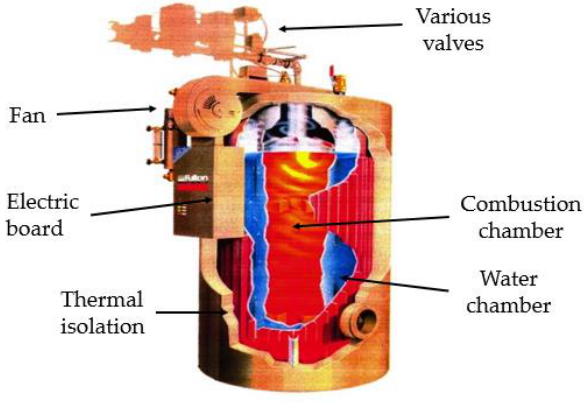
Figure 2. Vertical steam boiler two gas passes. It is a two-pass gas boiler; the first step is the combustion chamber, where the gases descend vertically, touching the bottom externally to the water as they rise to exit through the chimney. The second is distributed radially and rises externally to the water chamber to exit through the chimney.